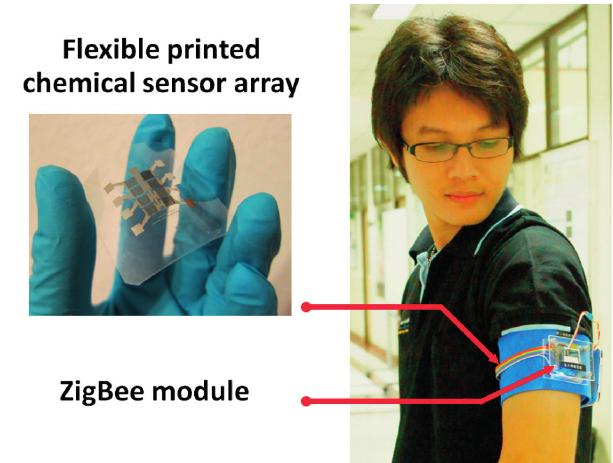
Figure 3. Prototype of a wearable e-nose based on using the flexible inkjet-printed chemical sensor array integrated in ZigBee wireless